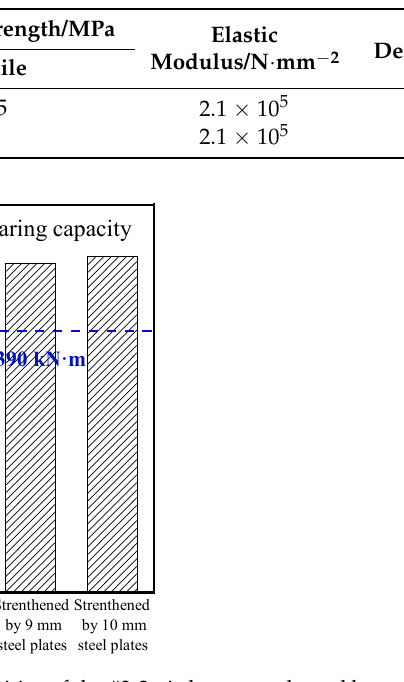
Table 2. Performance characteristics of the strengthening materials.